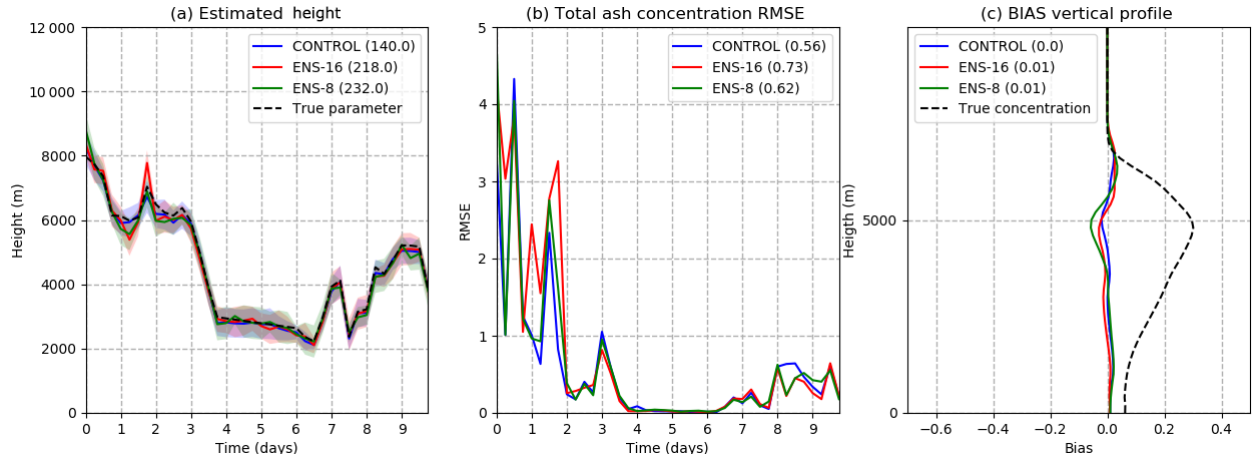
Figure 12. As in Fig. 11 but for the experiments CONTROL, ENS-16, and ENS-8.